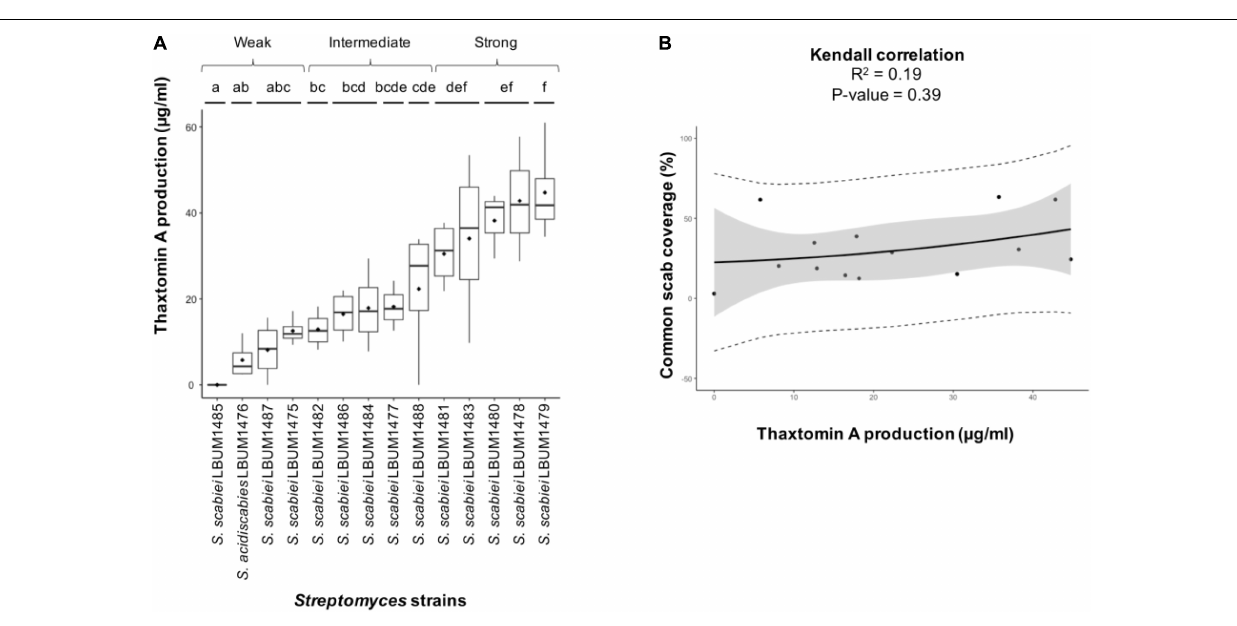
FIGURE 4 | Quantification of thaxtomin A production by the fourteen scab-causing strains of Streptomyces used in this study (A) and its correlation with the severity of common scab coverage symptoms observed on potato tubers in a previous study (Hudec et al., 2021) (B) . Lowercase letters above the bars refer to significant differences ( P < 0 .